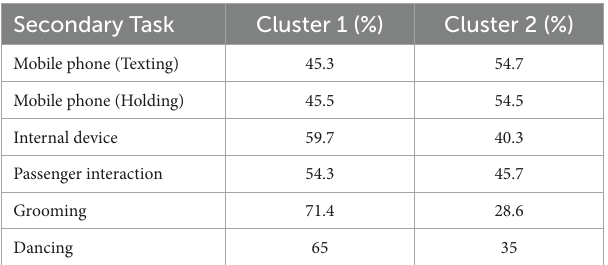
TABLE 5 Distribution of secondary tasks in